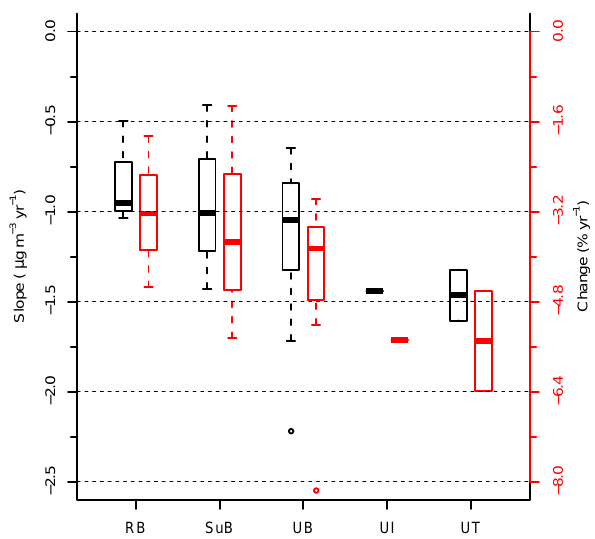
Figure 4. Boxplot of absolute and percentage significant slope of deseasonalized monthly mean PM 2 . 5 by station